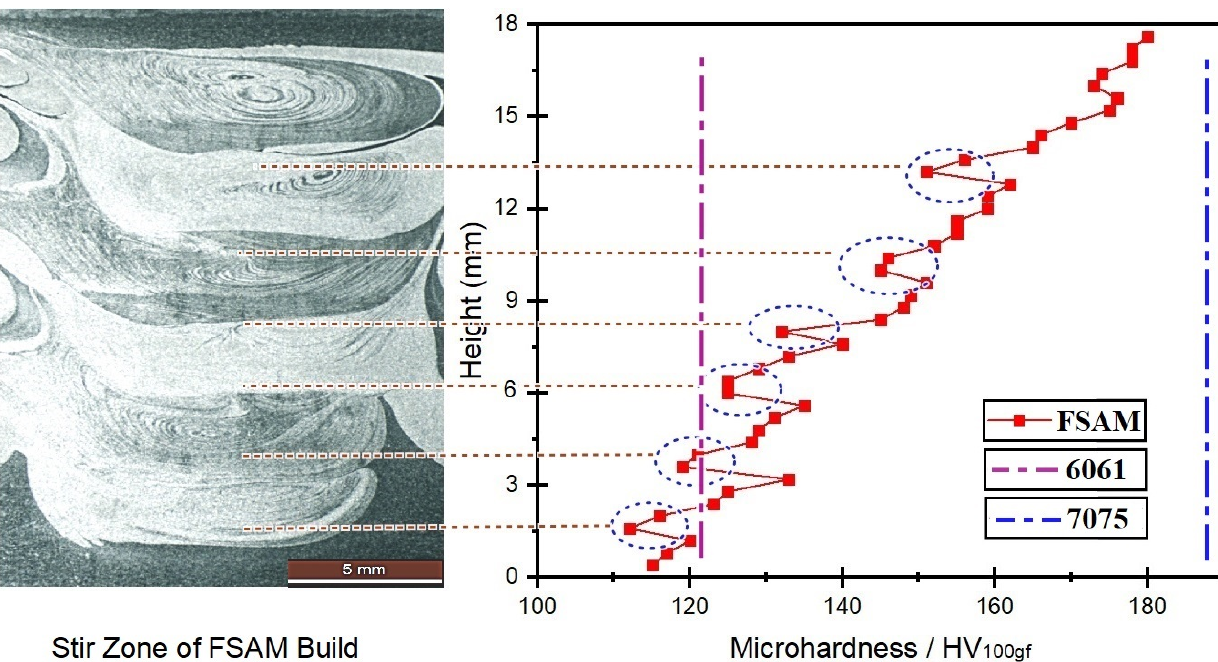
Figure 14. Microhardness analysis along vertical direction.